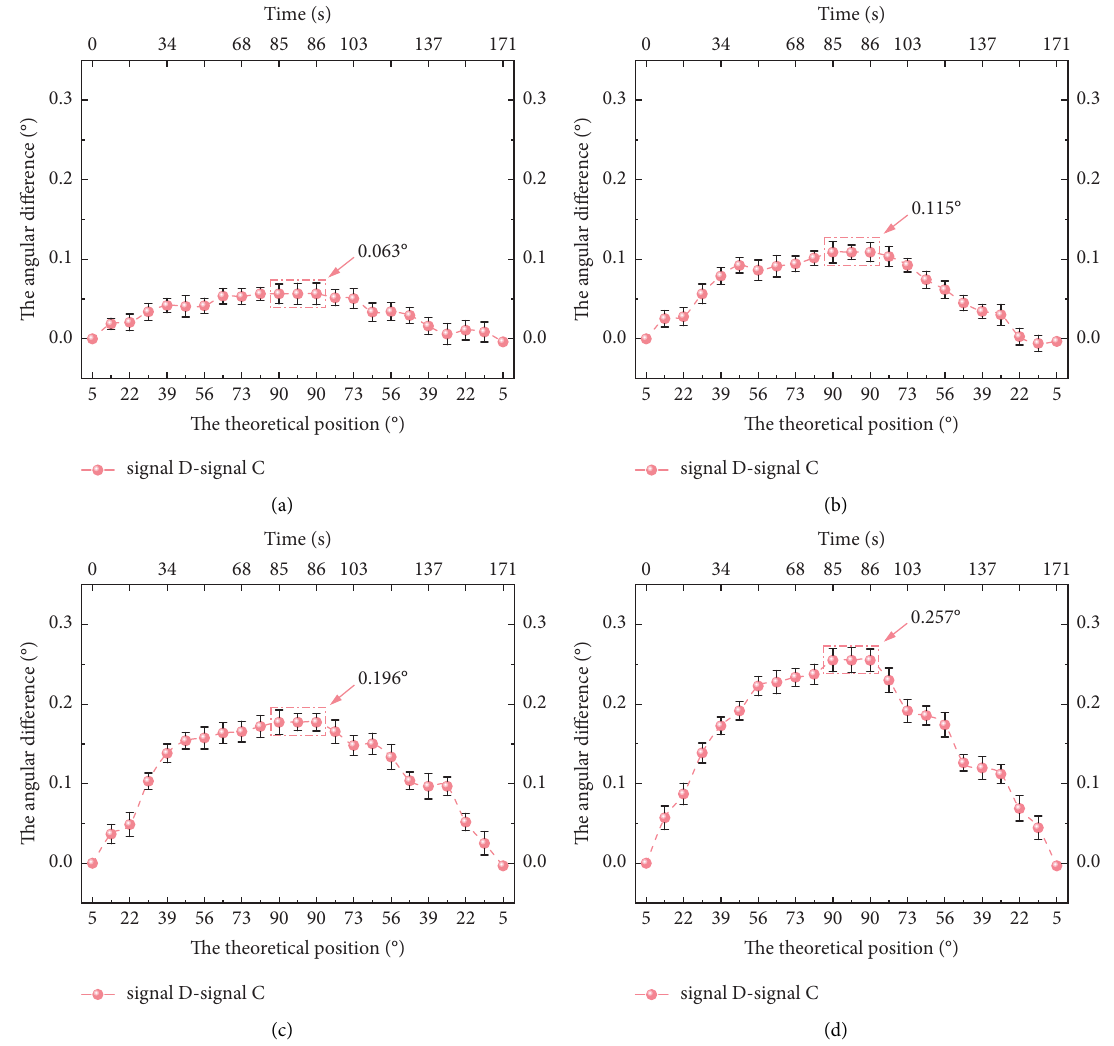
Figure 11: Te angle diference of diferent centerline deviations of bearings. (a) y